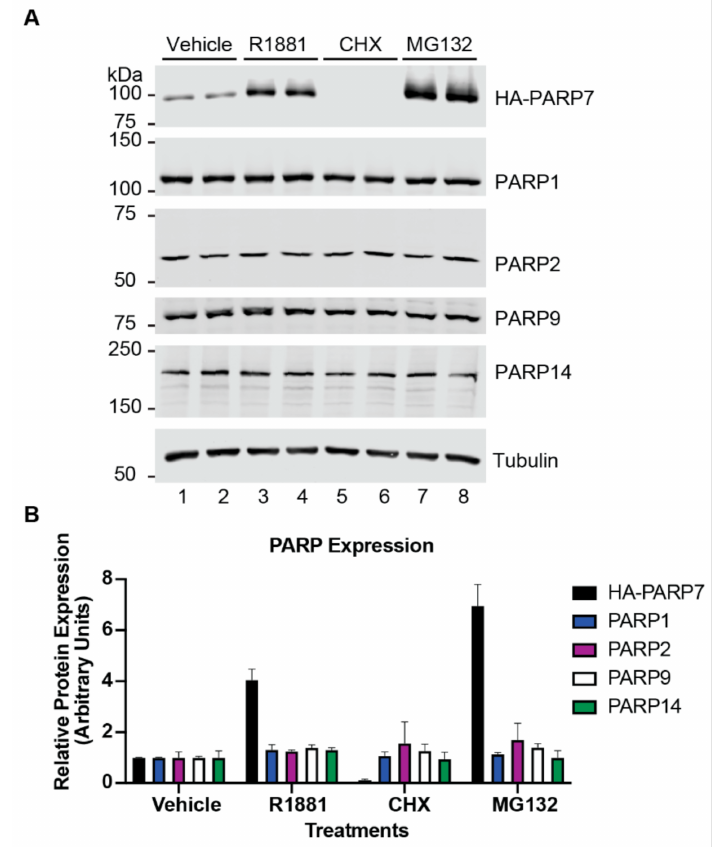
Figure 4. Characterization of androgen regulation and protein turnover of select PARPs in prostate cancer cells. ( A ) PC3-Flag-AR/HA-PARP7 cells were treated with androgen (2 nM R1881, 6 h), cycloheximide (100 µ g/mL CHX, 1 h), or MG132 (10 µ M, 2 h) and analyzed by immunoblotting. Two independent experiments are shown (odd numbered lanes are from experiment 1, even numbered lanes are from experiment 2). ( B ) Quantification of ( A ). Signal intensities for PARP protein levels were normalized by tubulin and scaled by setting the mean for vehicle treatment to 1. Plot shows mean ± SD from two independent